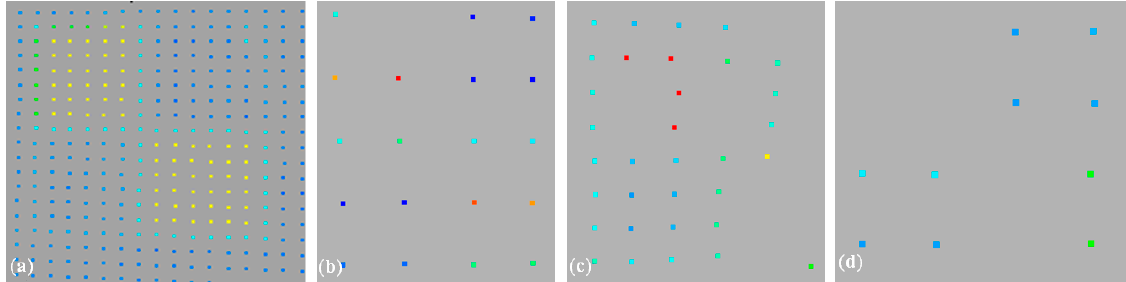
Figure 5. Scans of different qualities: ( a ) 142 regular point distribution targets ( b ) 99 regular scans of a lower density, ( c , d ) 97 irregular scan points, and the low completeness level is 106.